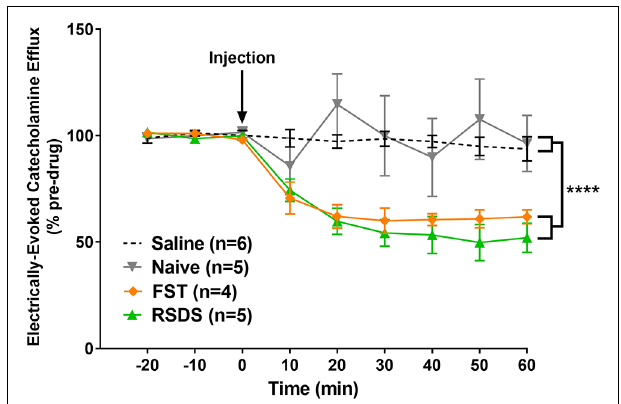
FIGURE 7 | Alcohol significantly reduced the measured catecholamine (CA) efflux in the basolateral amygdala (BLA) following locus coeruleus (LC) electrical stimulation of stressed subjects. Rats were exposed to either repeated social defeat stress or the forced swim test prior to being used to quantify LC-evoked CA release in the BLA as measured by fast-scan cyclic voltammetry. After a stable baseline was established, alcohol was injected (black arrow). In stressed subjects, those exposed to either repeated social defeat stress (RSDS) or forced swim test (FST), alcohol resulted in a significant decrease in the measured CA signal compared to non-stressed, naïve controls. Efflux values are presented as mean ( ± SEM) percent of a pre-injection baseline average. Saline: n = 6; Naïve: n = 5; FST: n = 4; RSDS: n = 5. **** p <